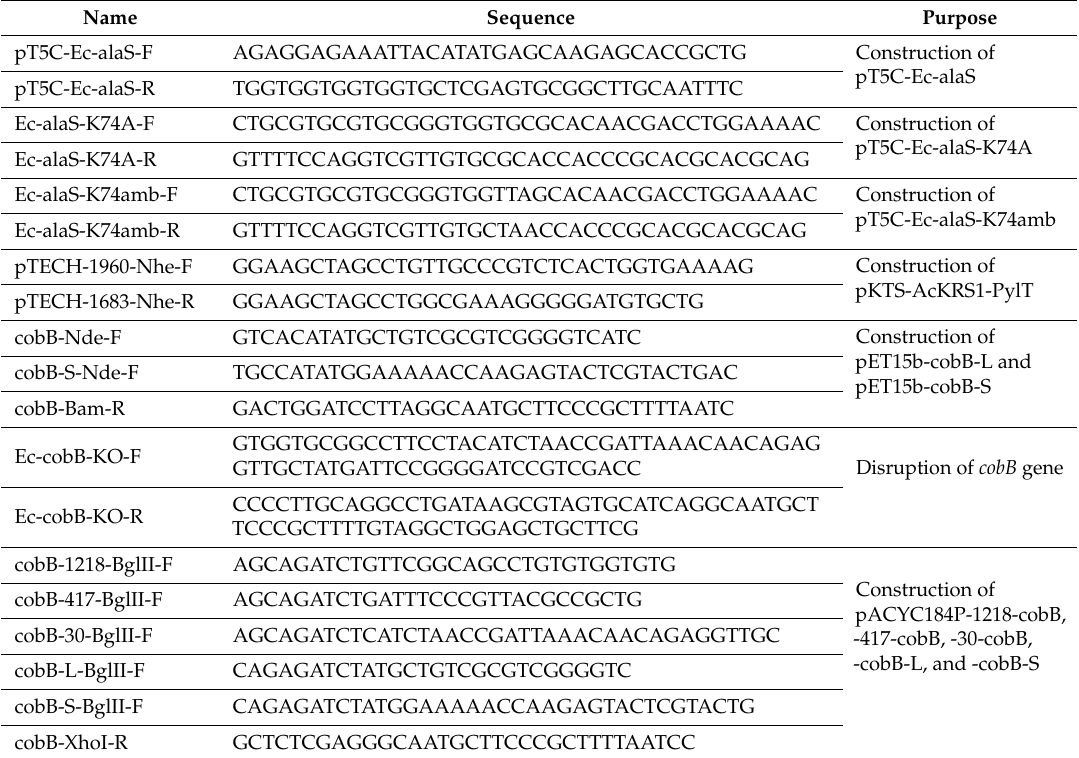
Table A2. List of primers for PCR.